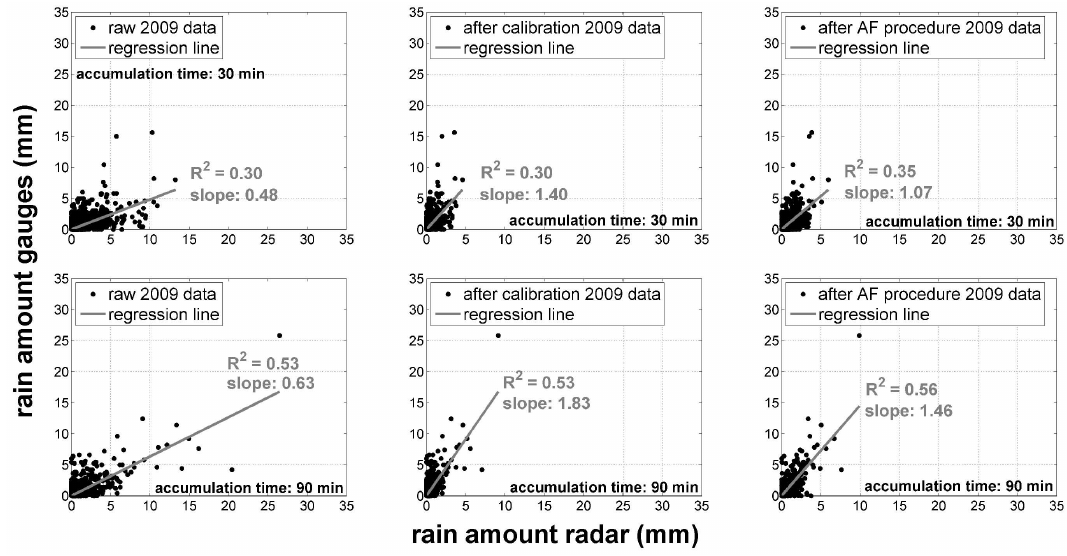
Fig. 16. Scatter plots of rainfall time series’ pairs, obtained during 2009 by Polar 55C and by each rain gauge located beyond a distance of 40km from radar. These refer to a time aggregation of 30 and 90 min (upper panels and lower panels, respectively) for the initial data sets (left panels), after calibration (middle panels) and after the adjustment procedure (right